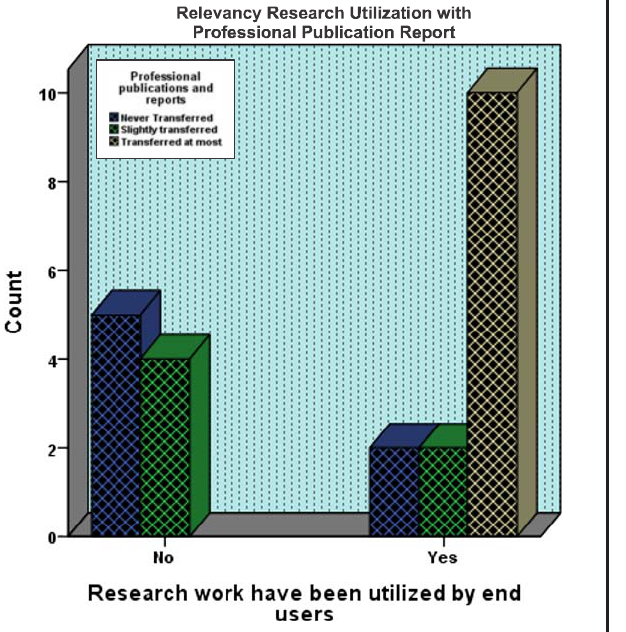
FIG. 2. ROLE OF PROFESSIONAL PUBLICATIONS TOWARDS UTILIZATION OF KNOWLEDGE CAPITAL